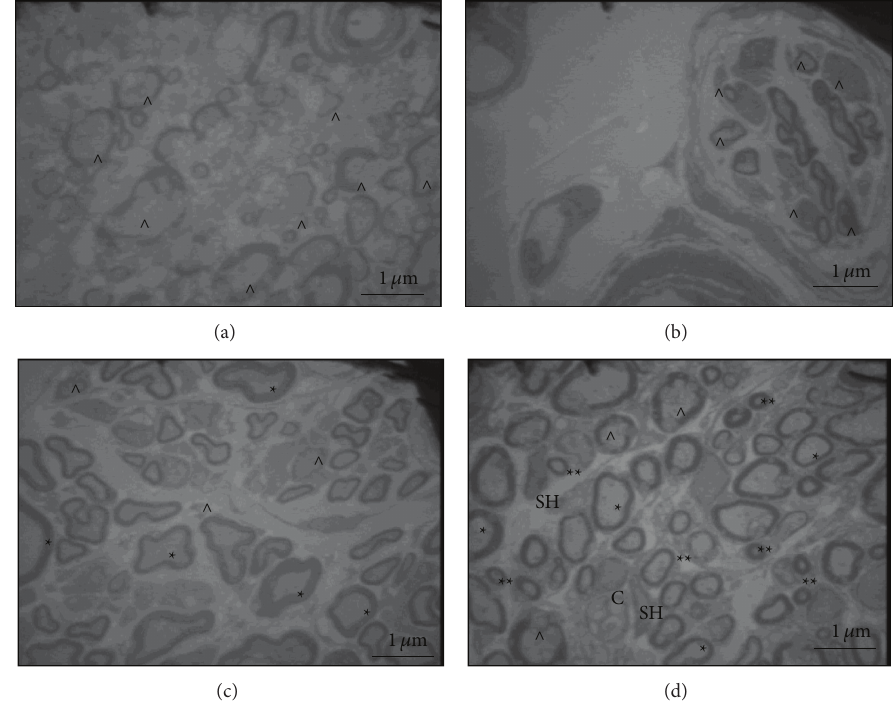
Figure 7: Electron photomicrography of distal stump to spinal cord. (a) Control; demyelinated axons and axons in process of demyelination ( ∧ ) (1600x). (b) FG; damaged axons ( ∧ ) (1600x). (c) PPN; myelinated axons (*), macrophage close to a damage axon (MA), and damaged axons ( ∧ ) (1600x). (d) PPN + BMSCs myelinated axons (*), newly formed axons (**), some damaged axons ( ∧ ), and Schwann cell (SH) beside its axon and BMSCs (C) beside a Schwann cell (SH) (1600x). The images were taken with a transmission electron microscope LEO 906 E. Calibration bar 1 𝜇 m.